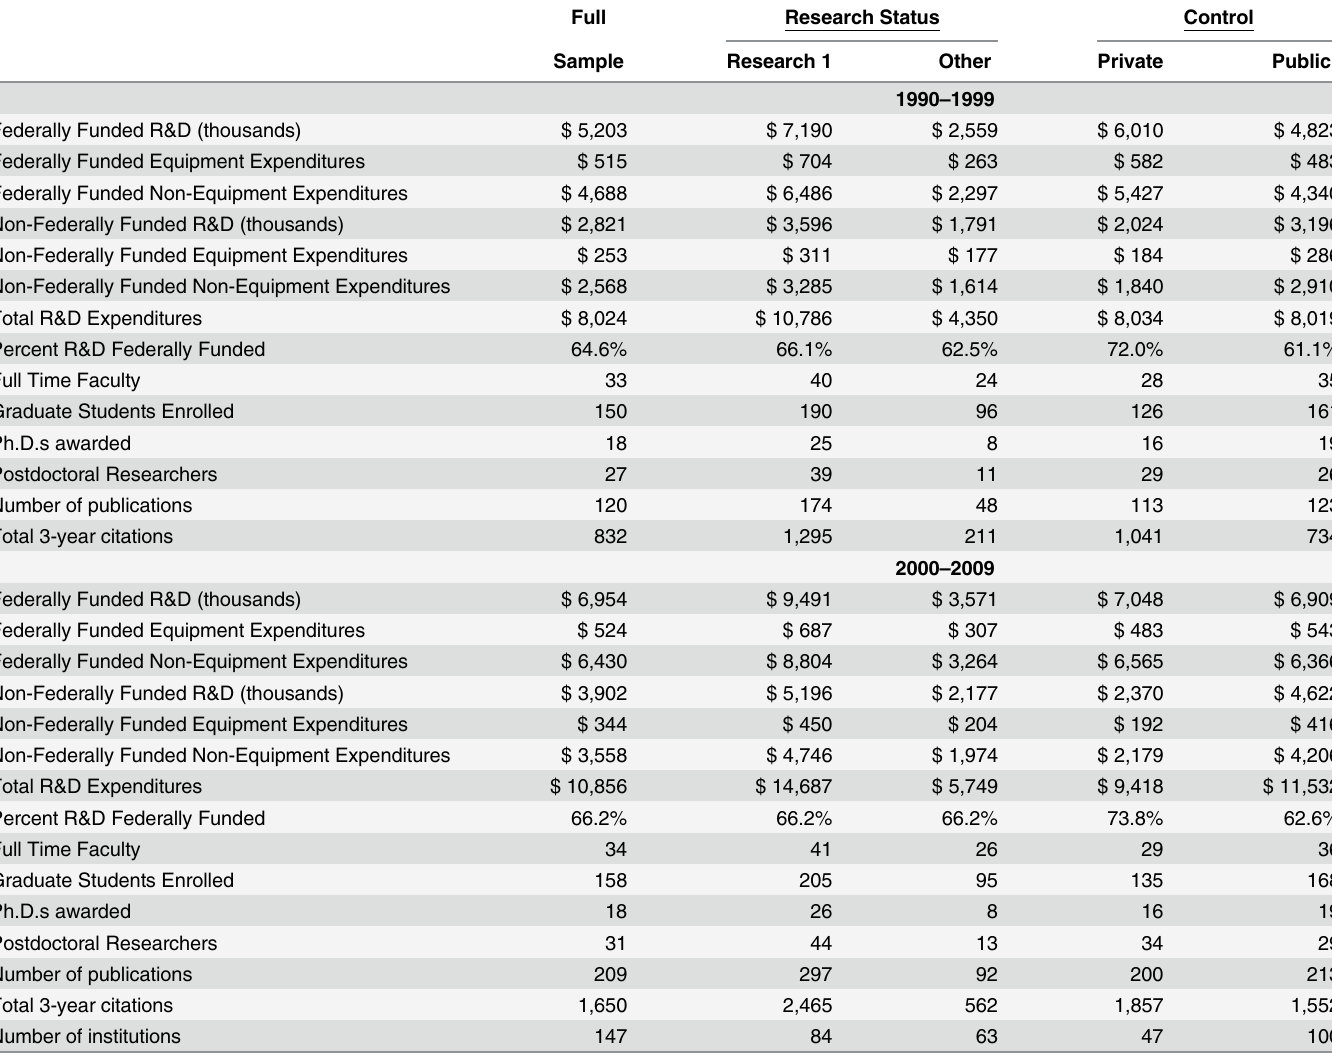
Table 1. Annual Average Values of Key Variables, by Decade and University